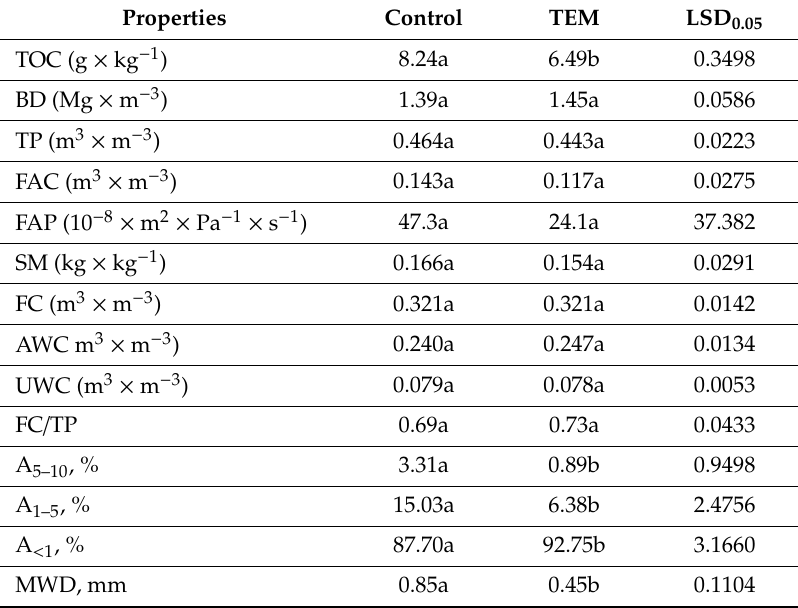
Table 2. The mean values of the investigated properties of the five-year experiment. Properties